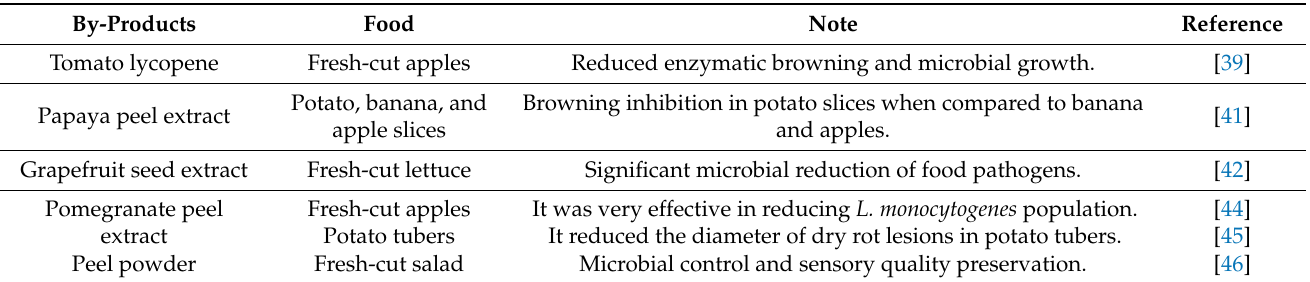
Table 2. Applications of by-products to fresh-cut